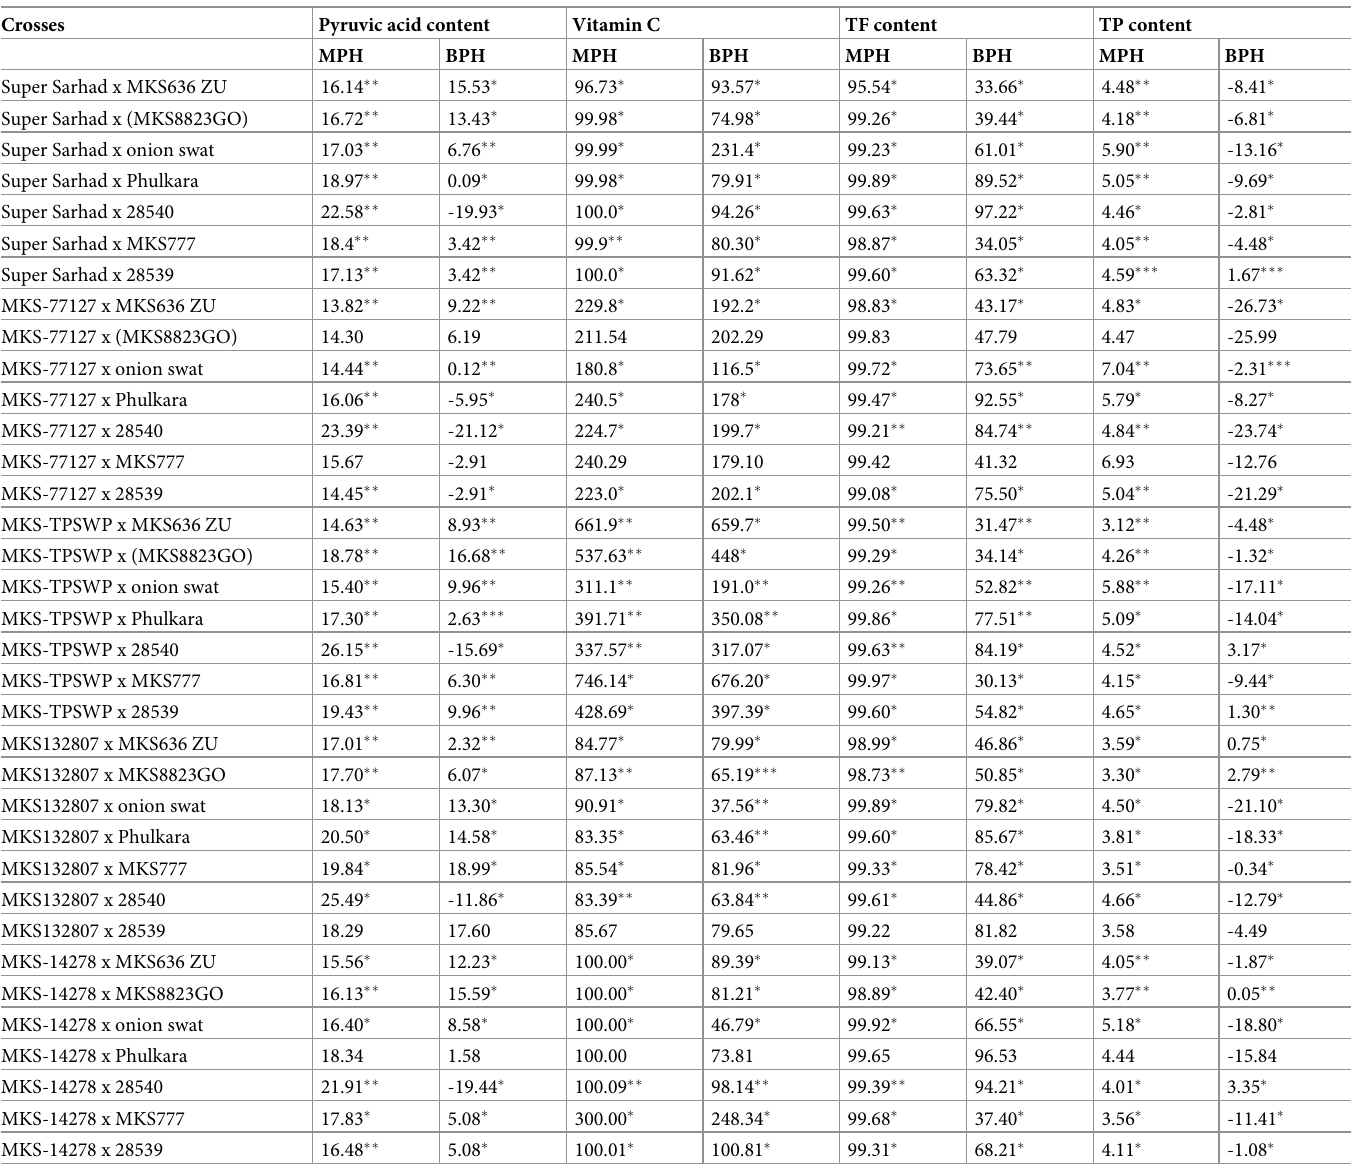
Table 8. Estimation of mid and better parent heterosis for four nutraceutical